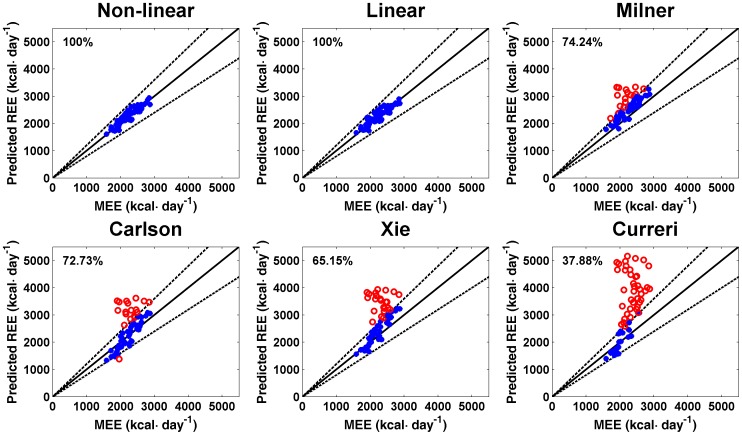
Reliabilities of different formulas.The solid line represents the ideal case of complete match between REE estimates and REE measurements (), and the dashed lines represent 20% over or below the ideal match. Data points that fall between the two dashed lines are indicated by blue “*”; those outside are indicated by red “o”. Percentage represents the proportion of data points that fell between the two dashed lines. MEE, measured resting energy expenditure.